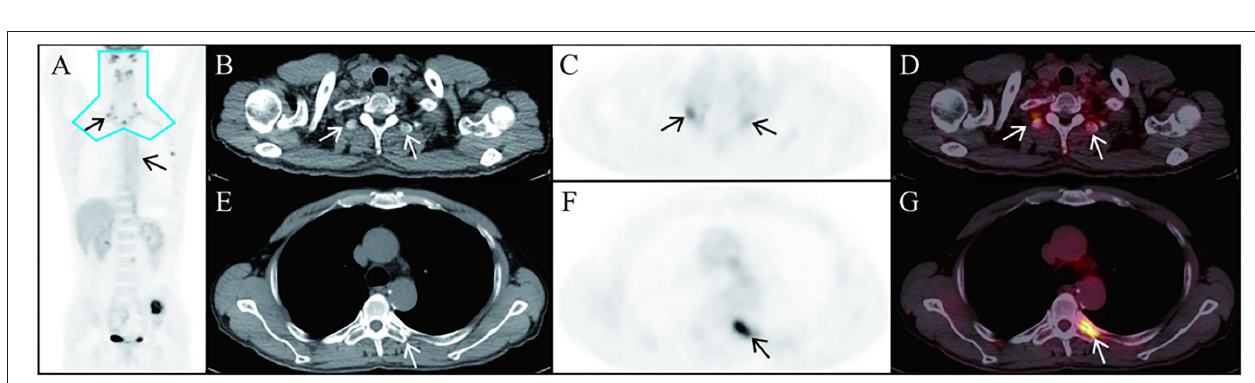
FIGURE 2 | In this case, 18F-FDG uptake (SUVmax, 6.5) is seen in the bilateral vertebrae and intercostal muscles. Representative brown adipose tissue in the thoracic vertebra transverse process [ (B–D) , arrows] and in posterior intercostal space [ (E–G) , arrowhead] in the axial CT, PET, and fusion PET/CT images is exhibited. The most common location for brown adipose tissue that is detectable in adults by PET/CT is the blue area in (A)